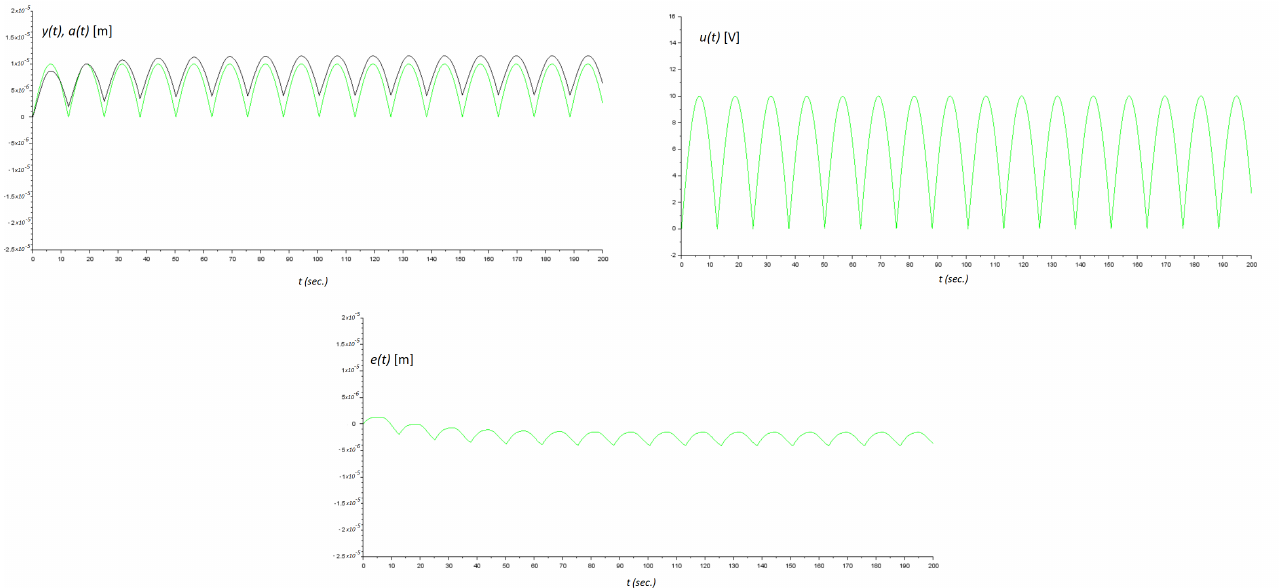
Figure 9. A control scheme for the positioning micromachine system using Xcos .